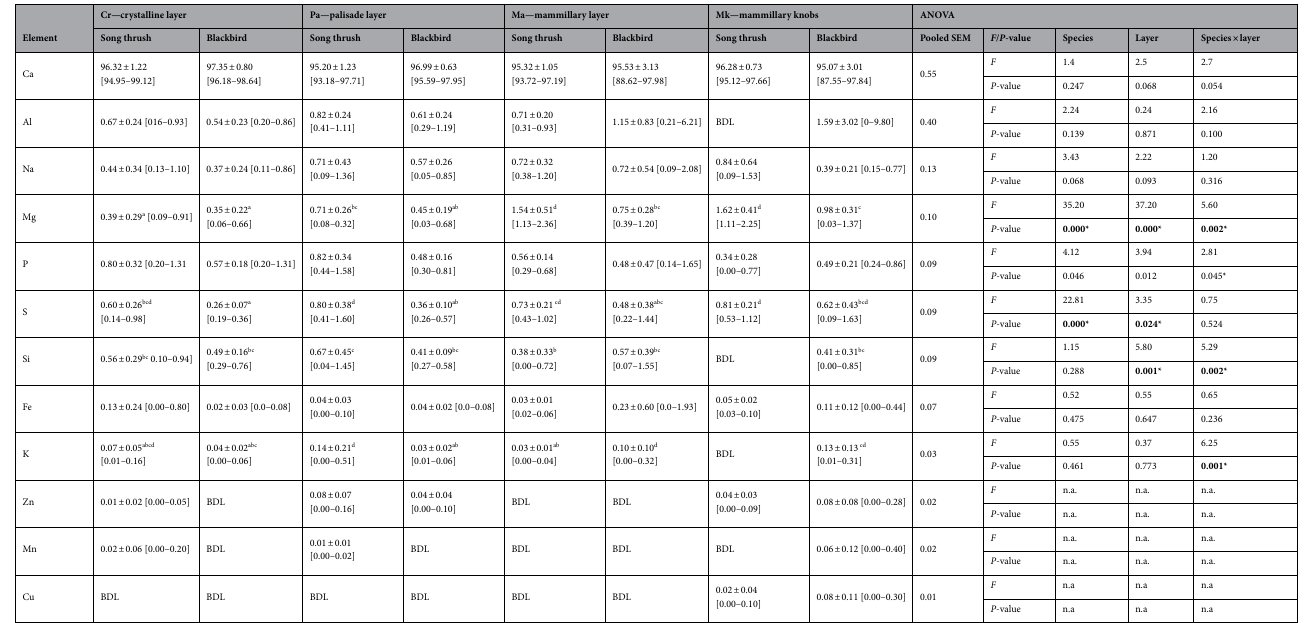
Table 4. Results of the SEM–EDS analysis of elemental content in different layers of blackbird and song thrush eggshell. Values are means, errors, and lower and upper quartiles (in brackets) for 10 eggshells of blackbird and 10 eggshells of song thrush (each for different egg). Statistically significant main effects are shown in bold and marked with *( P < 0.05). a,b,c,d No common superscript in a row indicates a statistical difference in elemental content in the shell layer. BDL all samples below the detection limit. n.a. not